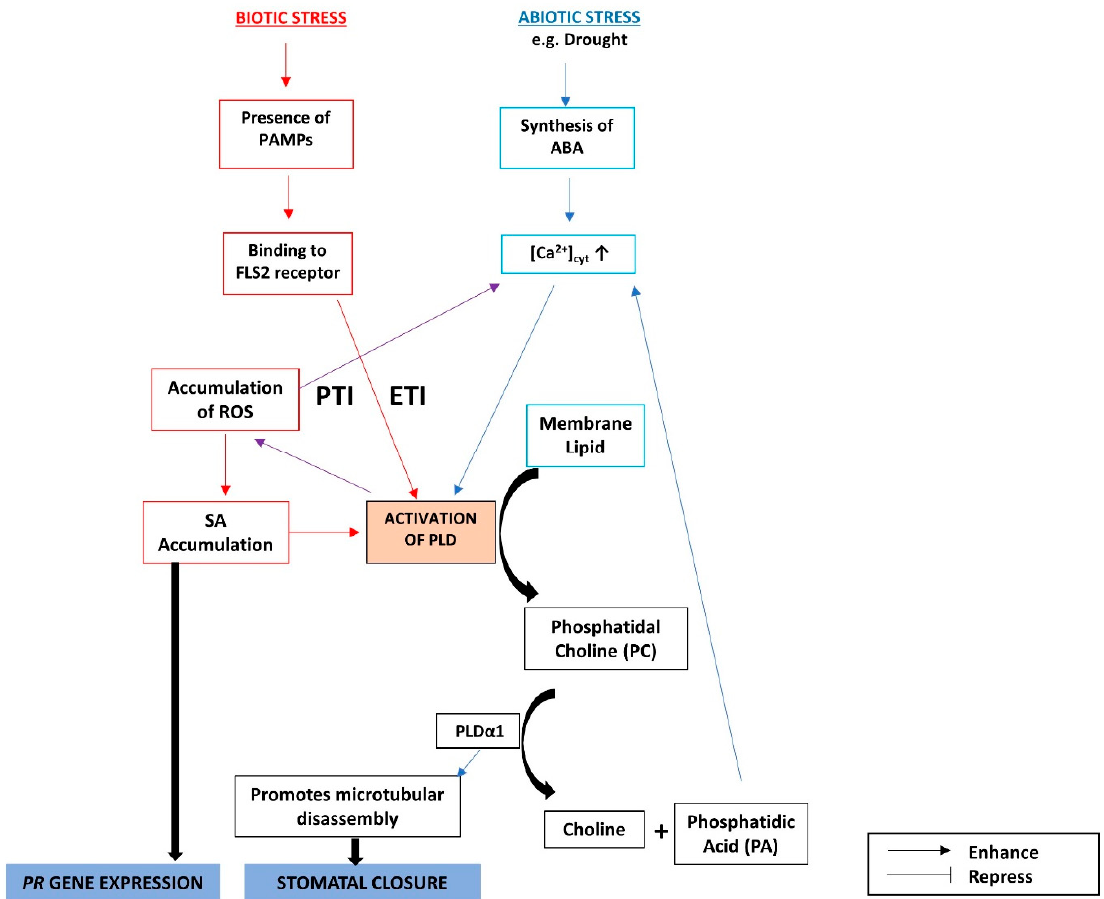
Figure 4. The crosstalks among ABA, SA, and phospholipid signaling during biotic and abiotic stress responses act through PLDs. PTI: PAMP-triggered immunity; ETI: effector-triggered immunity.